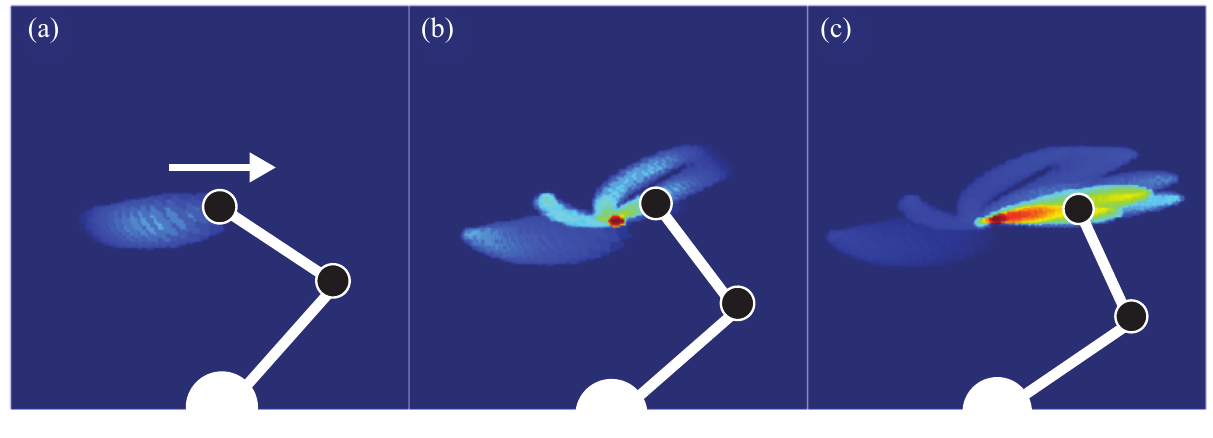
Figure 8. Example of a moving shape output. This figure shows three snapshots (order from left to right) of the output produced by a moving shape module in the case of non-zero optical